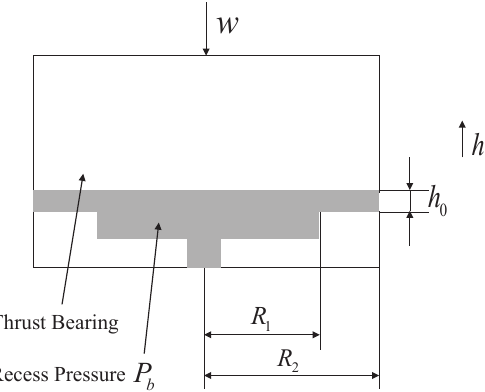
Figure 1. Schematic of hydrostatic thrust